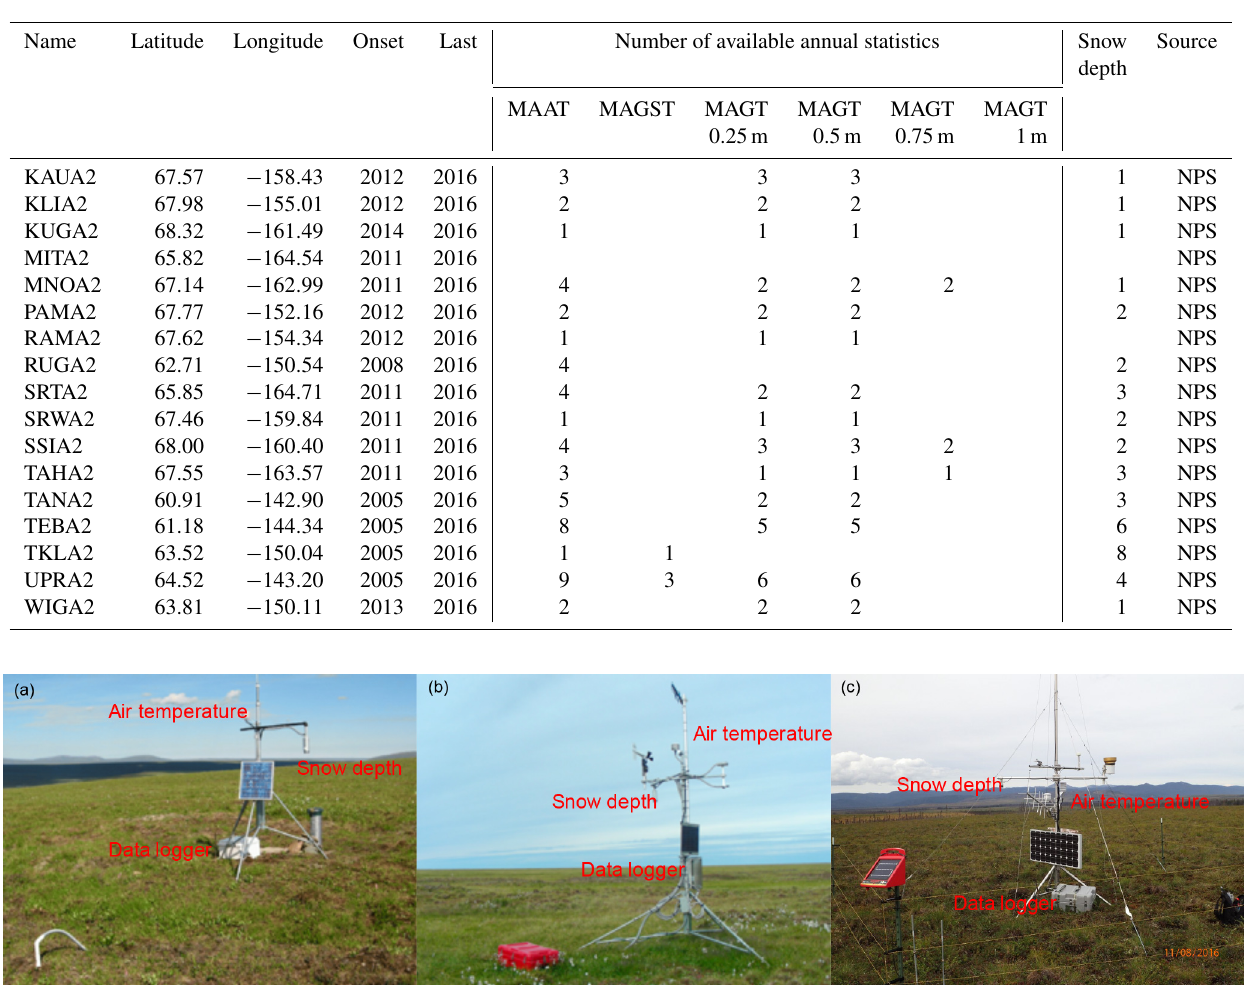
Figure 2. Typical permafrost observing stations. (a) Imnaviat site (68.64 ◦ N, 149.35 ◦ W) in the GI-UAF network (source: http://permafrost. gi.alaska.edu/site/im1, last access: 15 December 2018); (b) the Drew Point station (70.86 ◦ N, 153.91 ◦ W) in the USGS network (source: http://pubs.usgs.gov/ds/0977/DrewPoint/DrewPoint.html, last access: 15 December 2018); (c) the Wigand site (63.81 ◦ N, 150.109 ◦ W) in the NPS